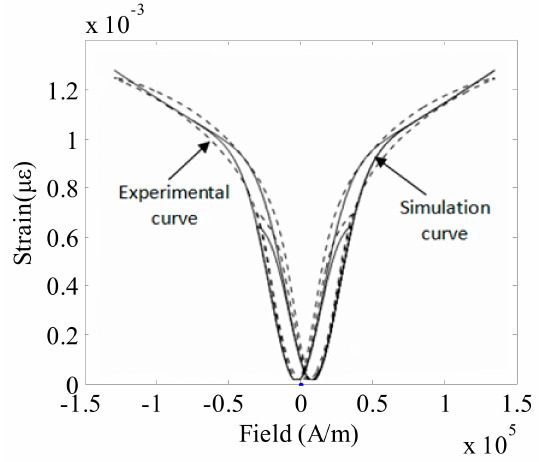
Figure 9. Simulation and experimental comparison curves of output displacement and magnetic field